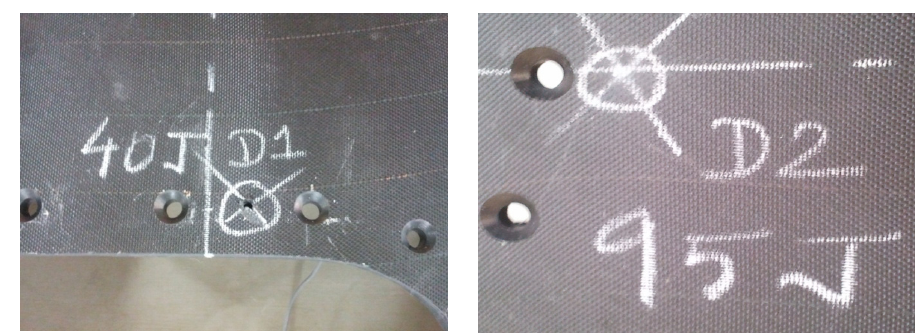
Figure 11. Impact damage on panel 1.